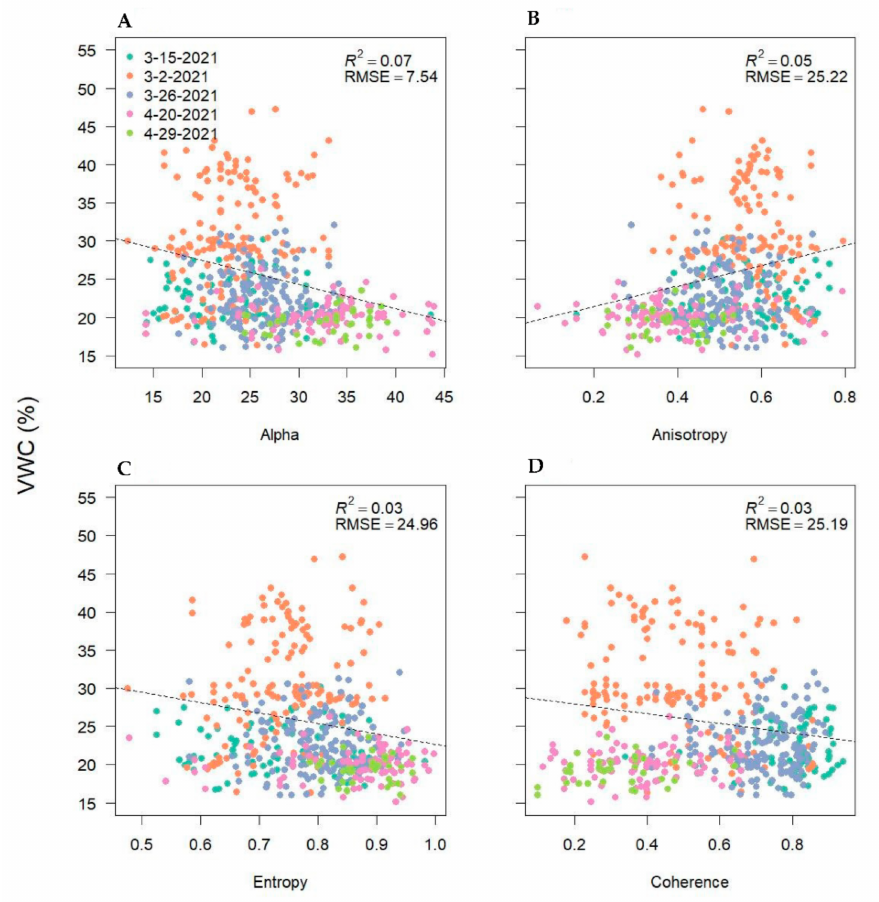
Figure A2. Volumetric water content (VWC) as a function of synthetic aperture radar polarimetric decompositions (alpha angle—( A ); anisotropy—( B ); entropy—( C )) and interferometric (InSAR) co- herence ( D ) from five soil moisture data collections in March and April adjacent to plot locations and across the seven study fields. VWC collections were timed with Sentinel-1 overpasses.